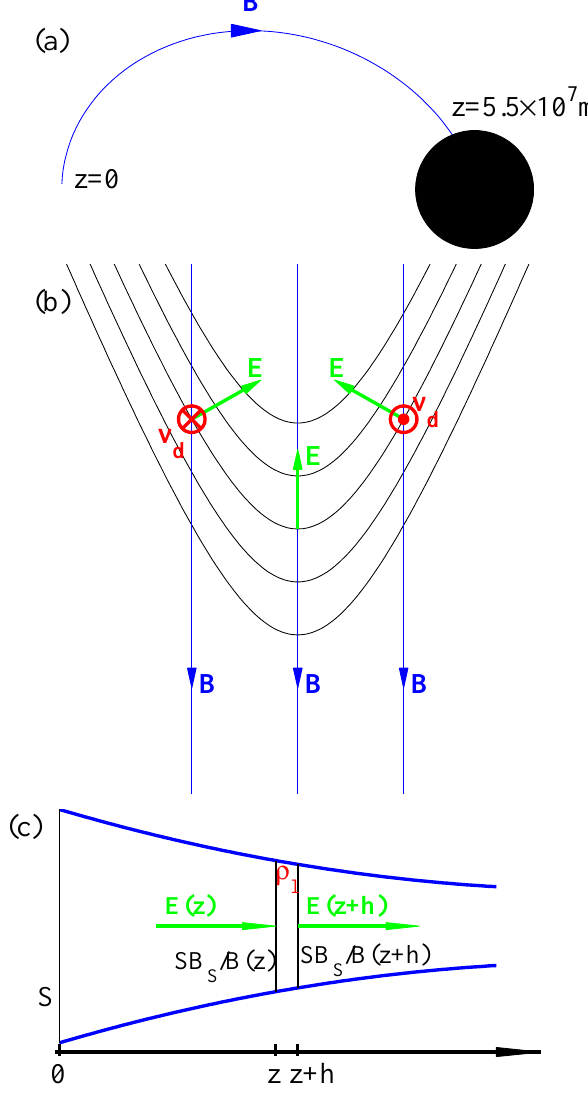
Fig. 1. Schematic of the geometry. (a) The plasma on a magnetic flux tube is modelled between the equatorial magnetosphere, where z = 0, and the ionosphere at z = 5 . 5 × 10 7 m. (b) Closeup of the cross section of an auroral arc. The black curves are equipotential lines. At the centre of the arc the electric and magnetic fields are parallel. Off centre, there is an E × B drift along the arc, into the plane of the paper on the left-hand side of the figure, and out of the plane on the right. (c) Illustration of the application of Gauss’s law to a flux tube segment. The net charge in the segment is ρ l h , and the flux tube cross section is SB S /B(z) , which reduces to S at z = 0.